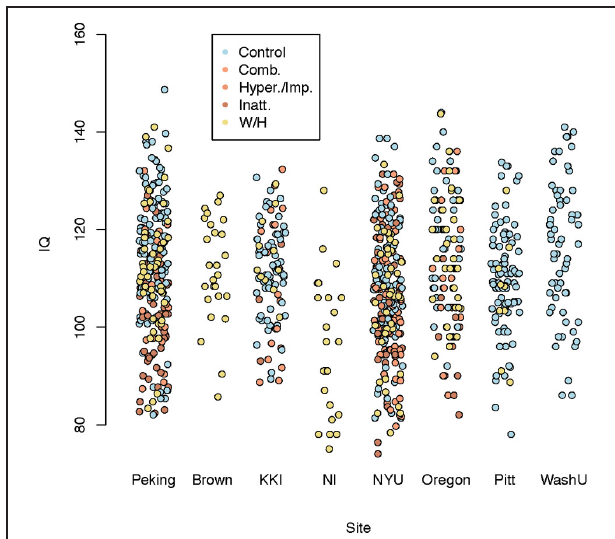
FIGURE 6 | Dot plot of composite intelligence quotients (average of all available IQ measurements per subject) by data contributing site color coded by disease